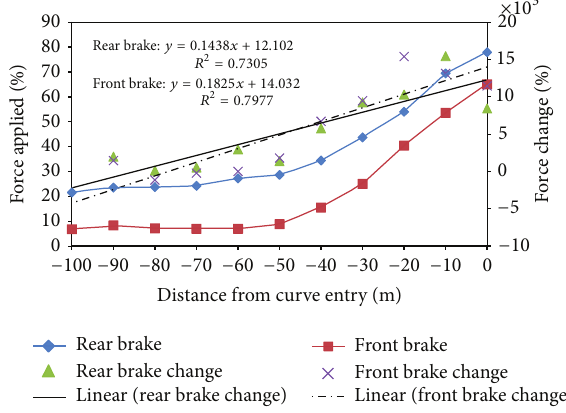
Figure 5: Rear brake and front brake applied